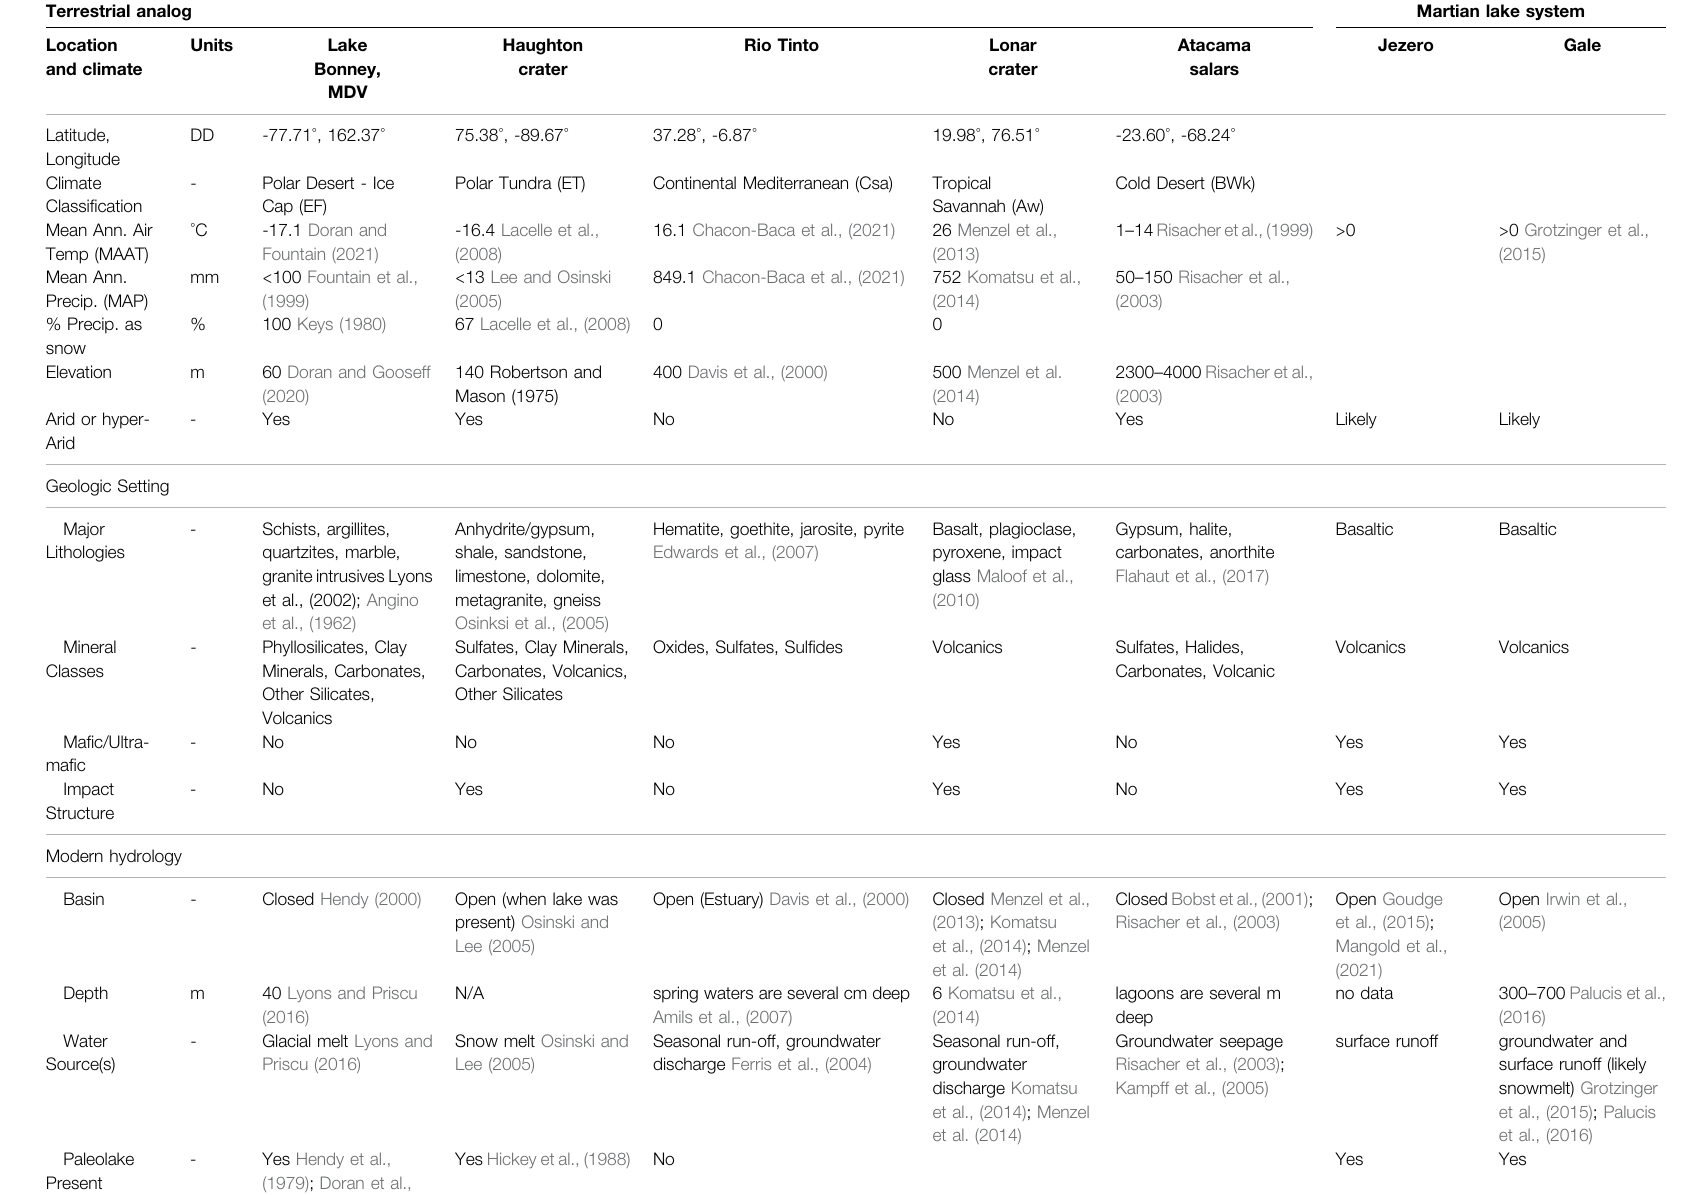
TABLE 1 | A cross-site comparison of selected environmental, mineralogical, chemical, and biological